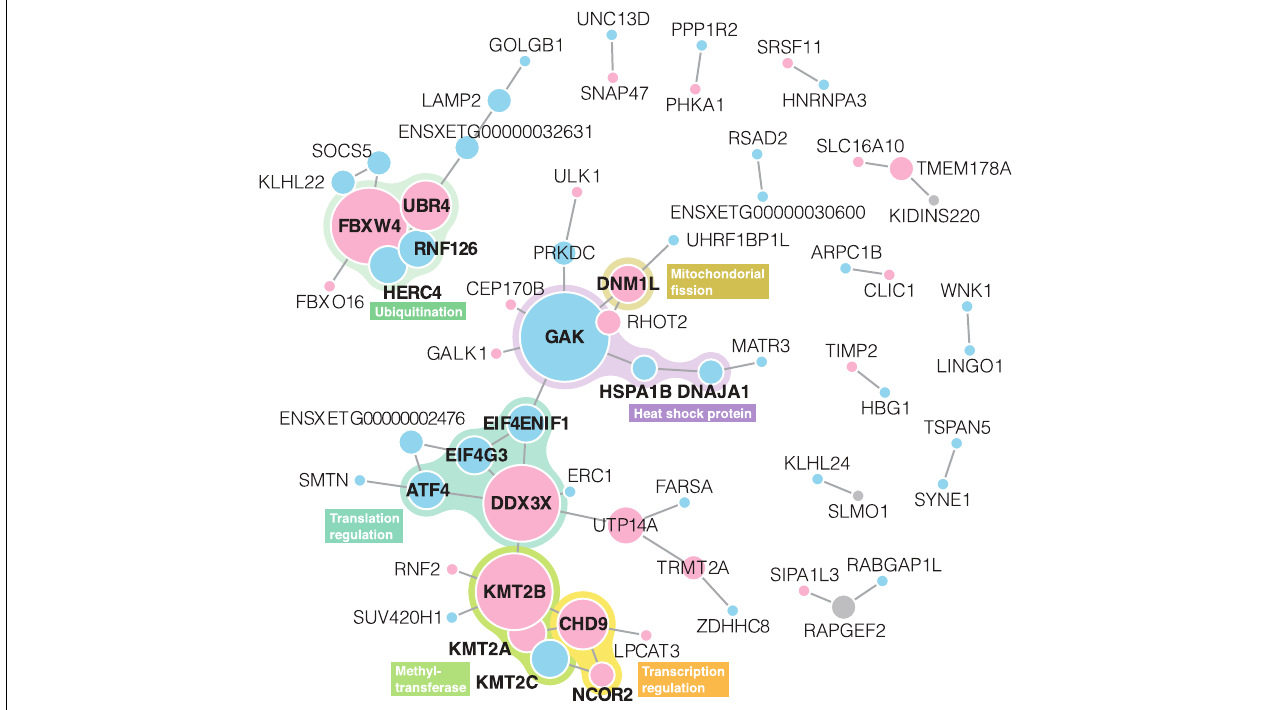
FIGURE 3 | Protein-protein interaction networks derived from the STRING web database. Node size represents degree centrality ( Supplementary Table 2 ). Gene symbols obtained in BLASTP annotation using X. tropicalis as a reference are presented in each node. Red and blue nodes represent proteins with upregulated and downregulated expressions, respectively. Gray nodes indicate that both upregulated and downregulated transcripts shared the annotations. Proteins written in bold letters are those mentioned in the main